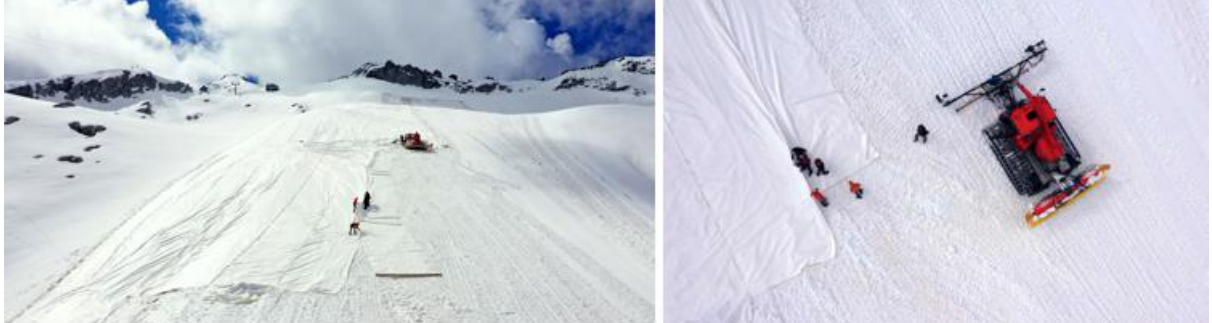
Figure 8. The covering of the Presena glacier in northern Italy (sources, [85,86]).